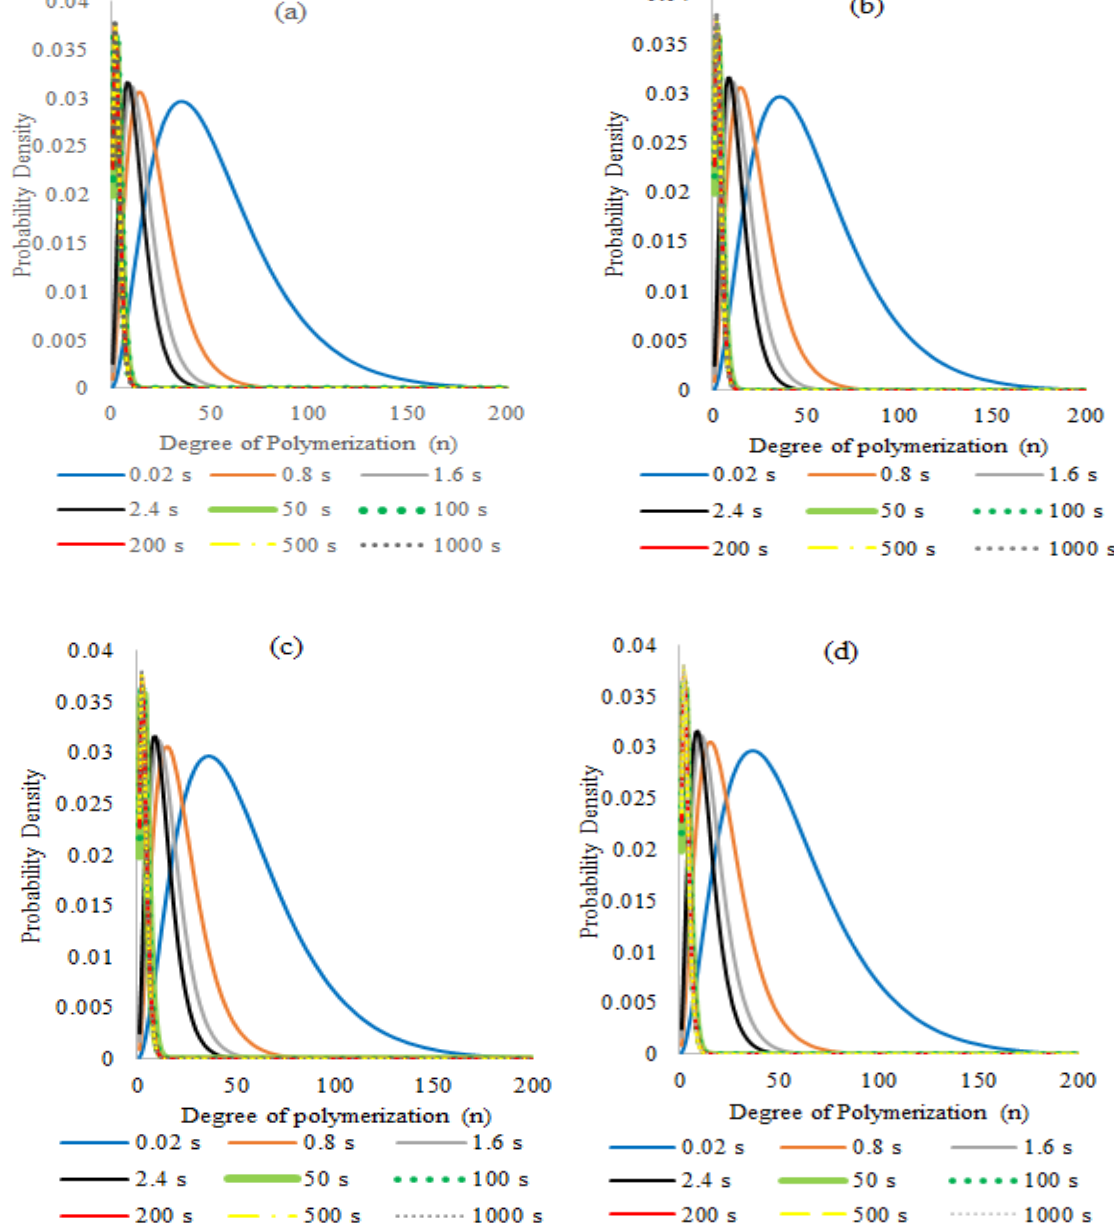
Figure 7. Molecular Weight Distributions calculated for the different polymer populations on the Nitroxide Mediated Oligomer pyrolysis simulation: ( a ) dead, ( b ) dormant, ( c ) living, and ( d ) living with nitroxide at the chain-end polymers. Reaction temperature 390 °C (see footnote of Table 5) and reaction formulation as in Table 2.